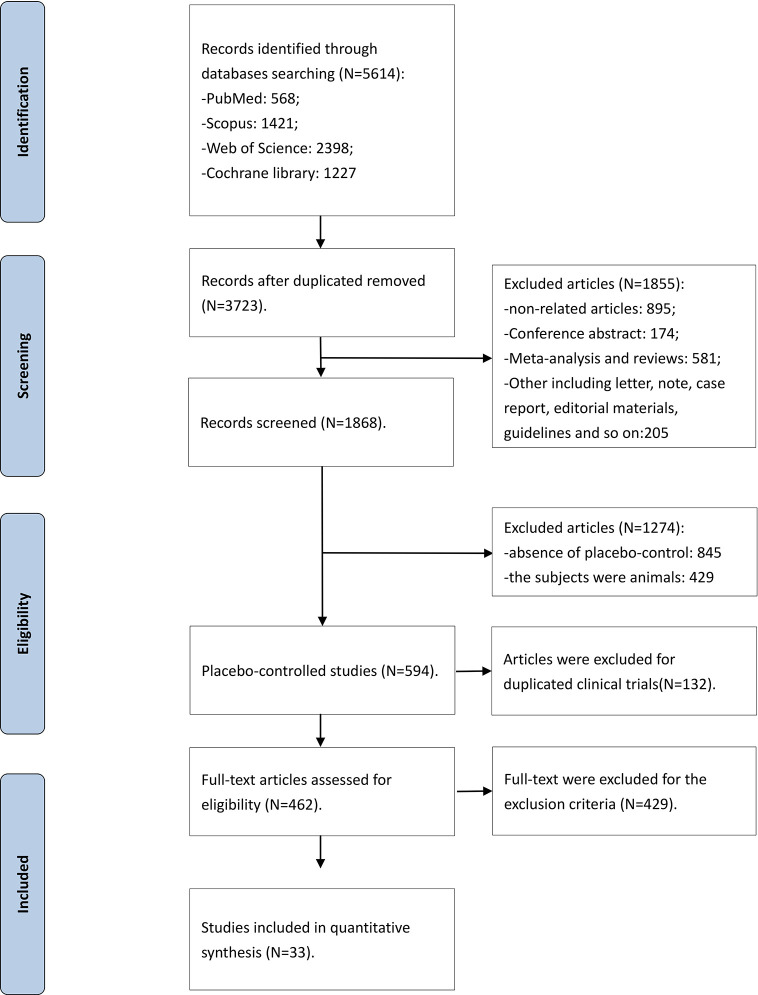
The flow diagram.